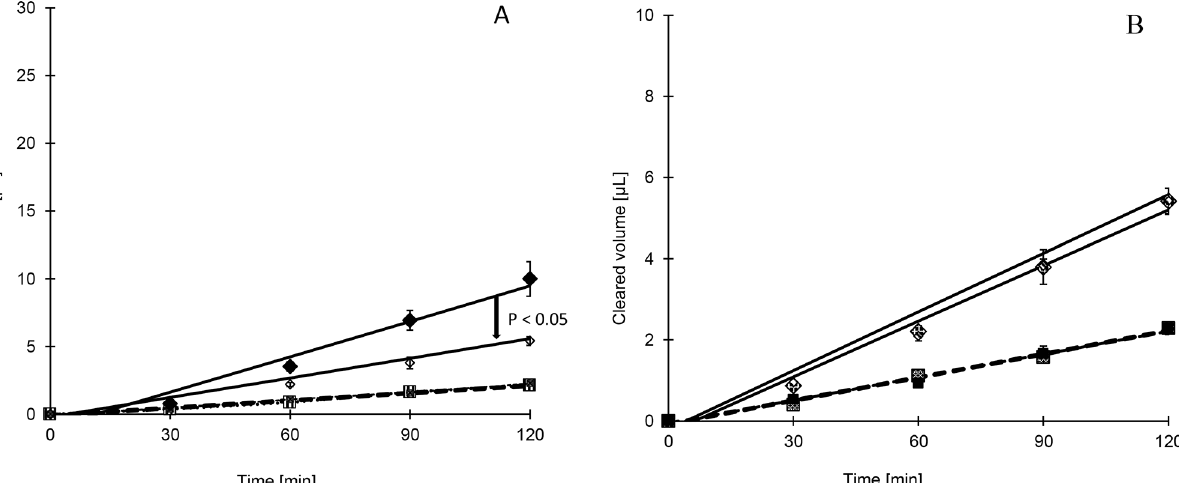
Fig 1. A). Ap-Bas (striped square) and Bas-Ap (solid diamond) transport of rhodamine123 alone, Ap-Bas (hashed square) and Bas-Ap (open diamond) transport of rhodamine123 when combined with mefloquine B). Ap-Bas (hashed square) and Bas-Ap (open diamond) transport of rhodamine123 when combined with mefloquine compared to Ap-Bas (solid square) and Bas-Ap (hashed diamond) transport of rhodamine123 when co-incubated with mefloquine and artesunate (N = 3, Mean ± SEM)